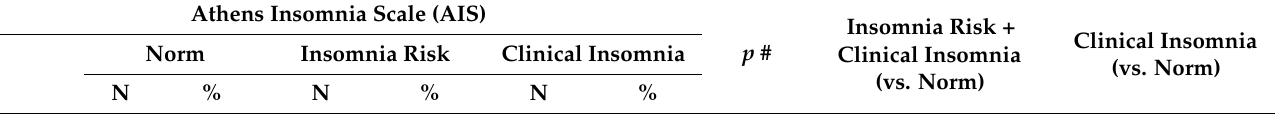
Table 4. Unfavorable emotional behavior and the risk of sleep disorders in